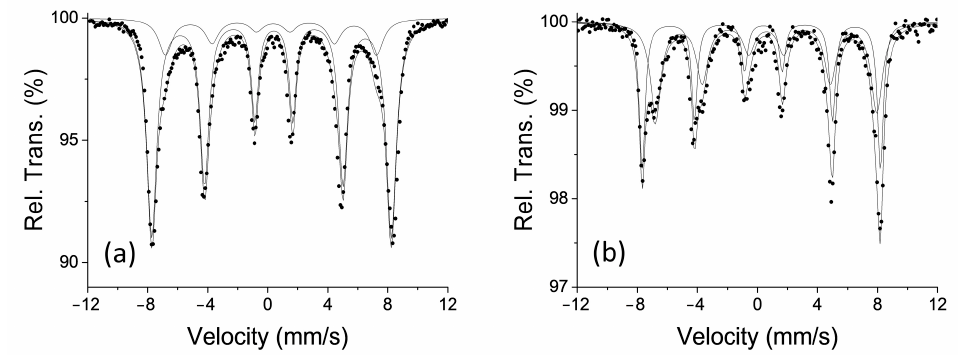
Figure 3. Mossbauer spectrum of coated RVC. ( a ) dip coated, ( b ) galvanostatically coated.